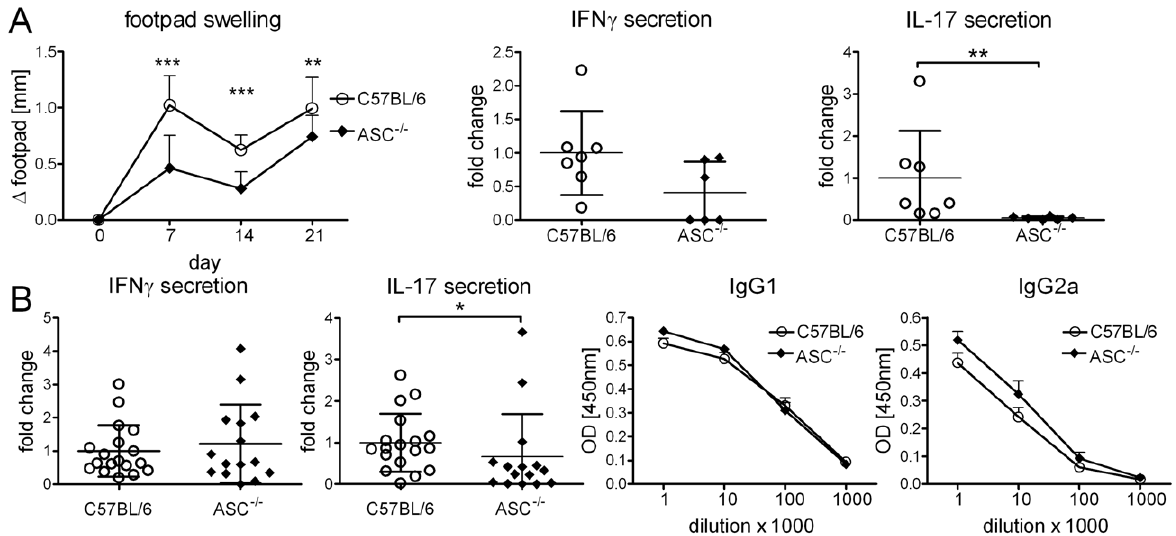
Figure 6. Partial contribution of ASC to DDA/TDB adjuvanticity. Footpad swelling, IFN c and IL-17 secretion in ASC 2 / 2 and C57BL/6 controls ( A ). Data presented as mean 6 SD pooled from 2 independent experiments with 3–5 mice/group. IFN c , IL-17 secretion and H1-specific antibodies in ASC 2 / 2 and C57BL/6 controls; base of tail immunization ( B ). Data presented as mean 6 SD pooled from 3 independent experiments with 5–6 mice/ group. Re-stimulation of cells isolated from the draining lymph